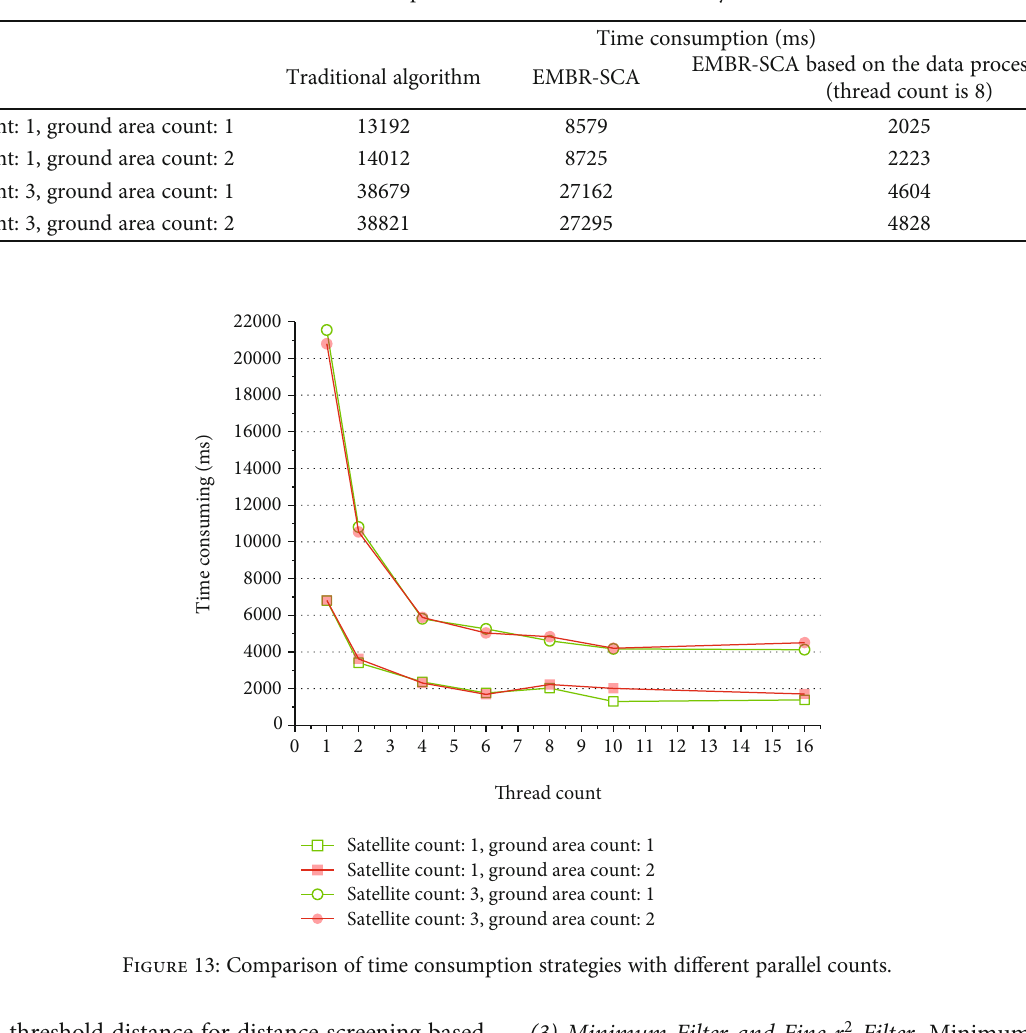
Table 5: Comparison of the calculation e ffi ciency.